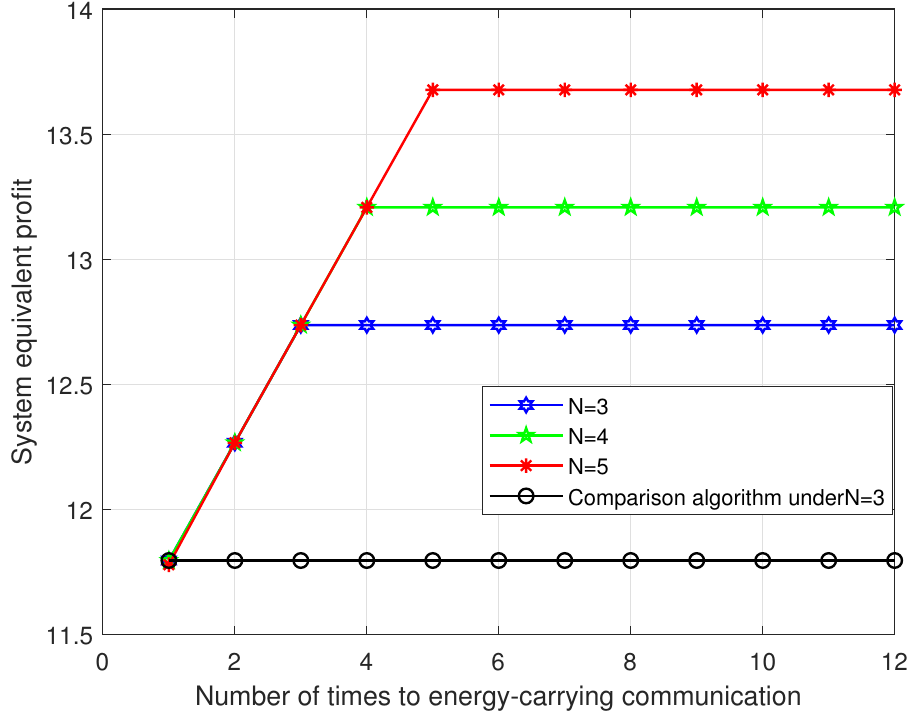
Figure 10. Comparison of cumulative energy based on SWIPT and non-cumulative energy based on SWIPT under